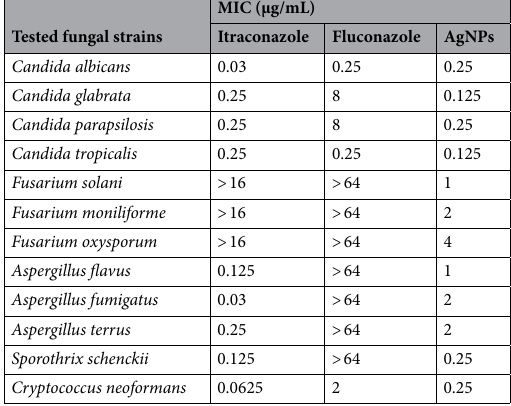
Table 1. Antifungal activity of Itraconazole, Fluconazole and